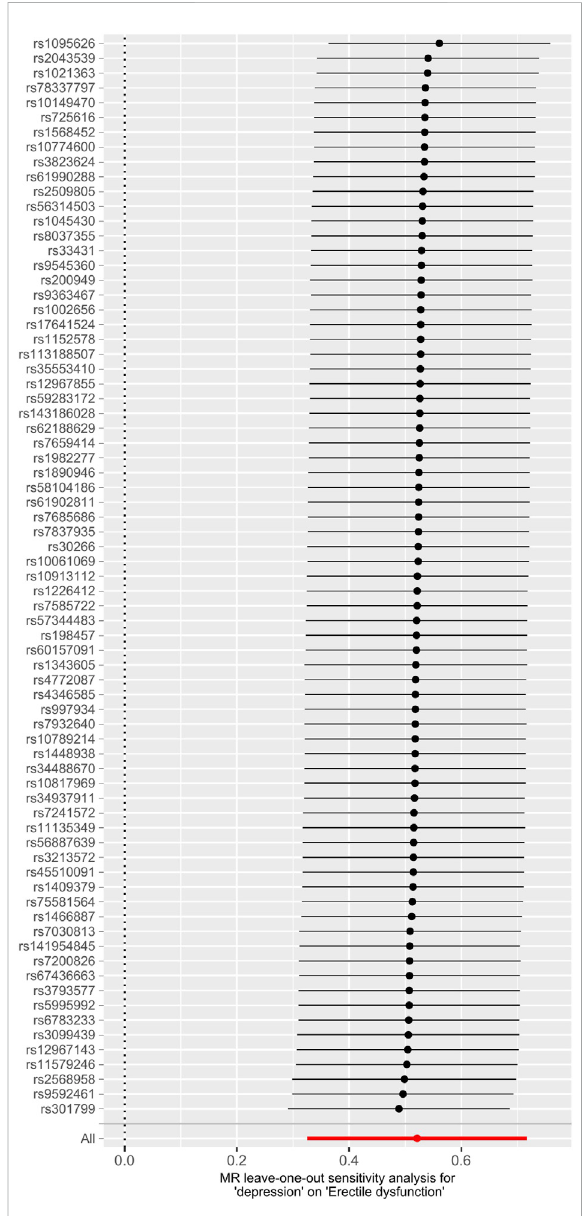
FIGURE 5 Leave-one-out analysis of depression on ED. Abbreviations: ED, erectile dysfunction; MR, Mendelian